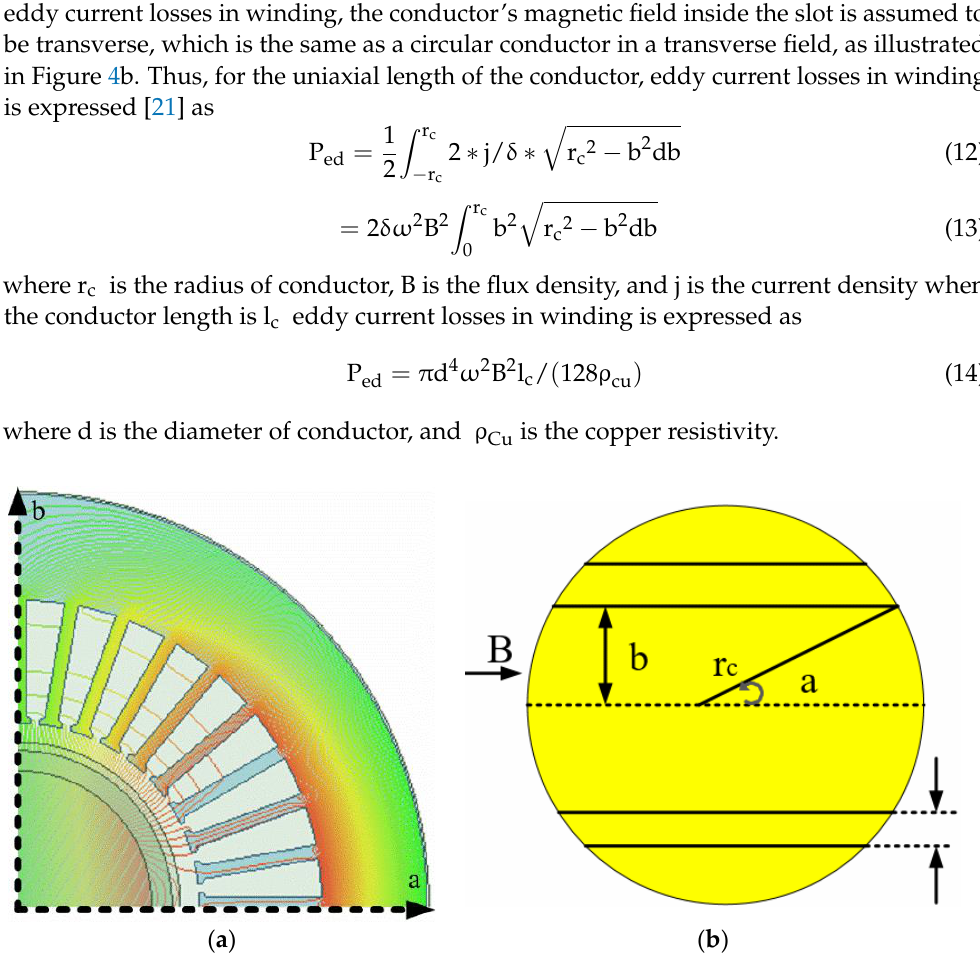
Figure 4. Eddy current losses in winding. ( a ) Leakage magnetic field distribution for the slots. ( b ) The circular conductor inside the transverse field.